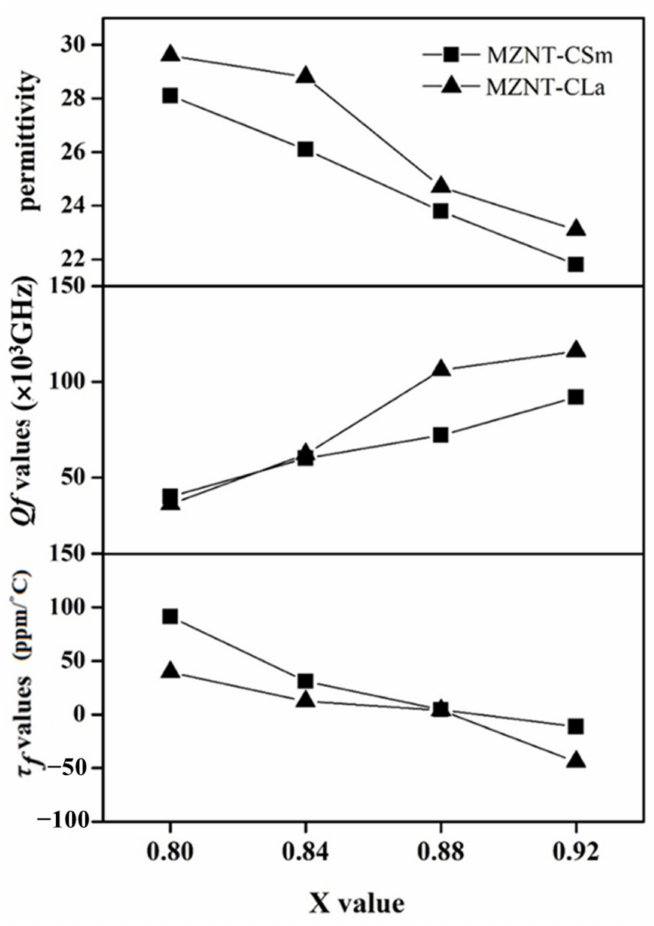
Figure 8. The dielectric properties of the x(Mg 0.6 Zn 0.4 ) 0.95 Ni 0.05 TiO 3 -(1 − x)Ca 0.6 La 0.8/3 TiO 3 sintered at 1225 ◦ C/Ca 0.8 Sm 0.4/3 TiO 3 sintered at 1250 ◦ C as a function of the x